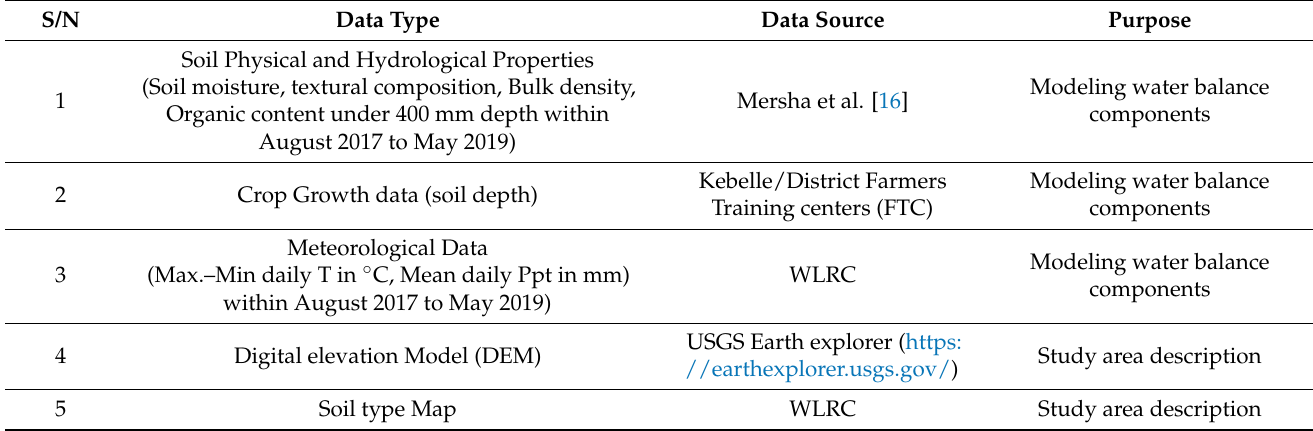
Table 1. Data type used in the study and their respective